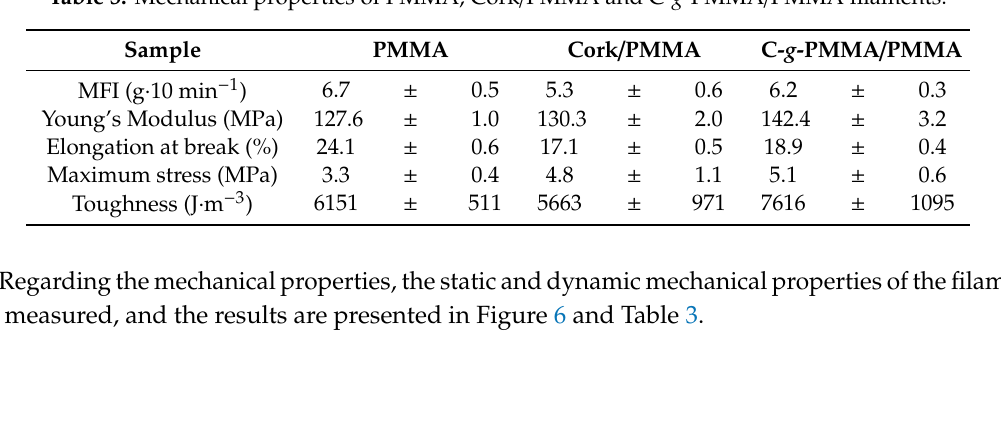
Figure 5. SEM images of the filaments: PMMA ( a ); Cork / PMMA ( b ), C- g -PMMA / PMMA ( c ), cross-section of the failure zone of filaments: PMMA ( d ); Cork / PMMA ( e ), C- g -PMMA / PMMA ( f ) as well as the EDX mapping of the failure zone of C- g -PMMA / PMMA ( g ). Table 3. Mechanical properties of PMMA, Cork / PMMA and C- g -PMMA / PMMA